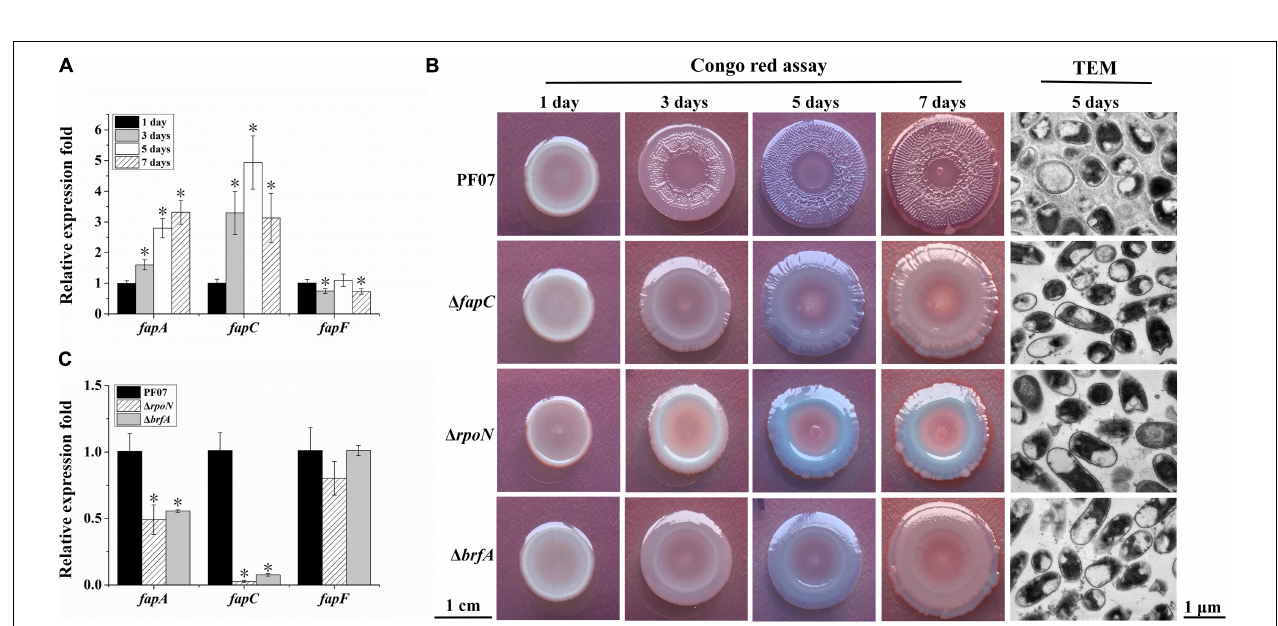
FIGURE 3 | Expression analyses of fap genes and macrocolony biofilm observation. (A) Expression changes of fap genes over time for PF07 on tryptone plates. (B) Macrocolony biofilms observed by Congo red assay (scale bar = 1 cm) and TEM (scale bar = 1 µ m). (C) Expression changes of fap genes in 5-day-old